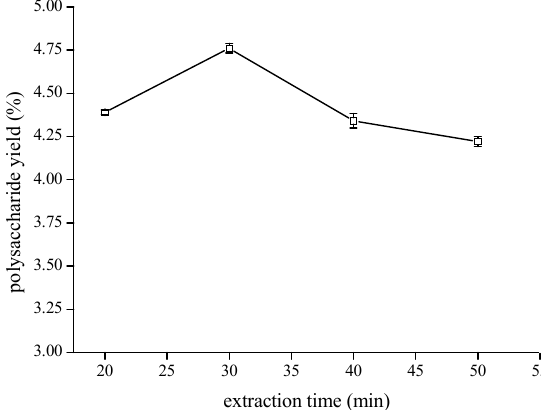
Figure 3. Effect of extraction time on polysaccharide yield (w/w dry crushed material %) from TCBL.